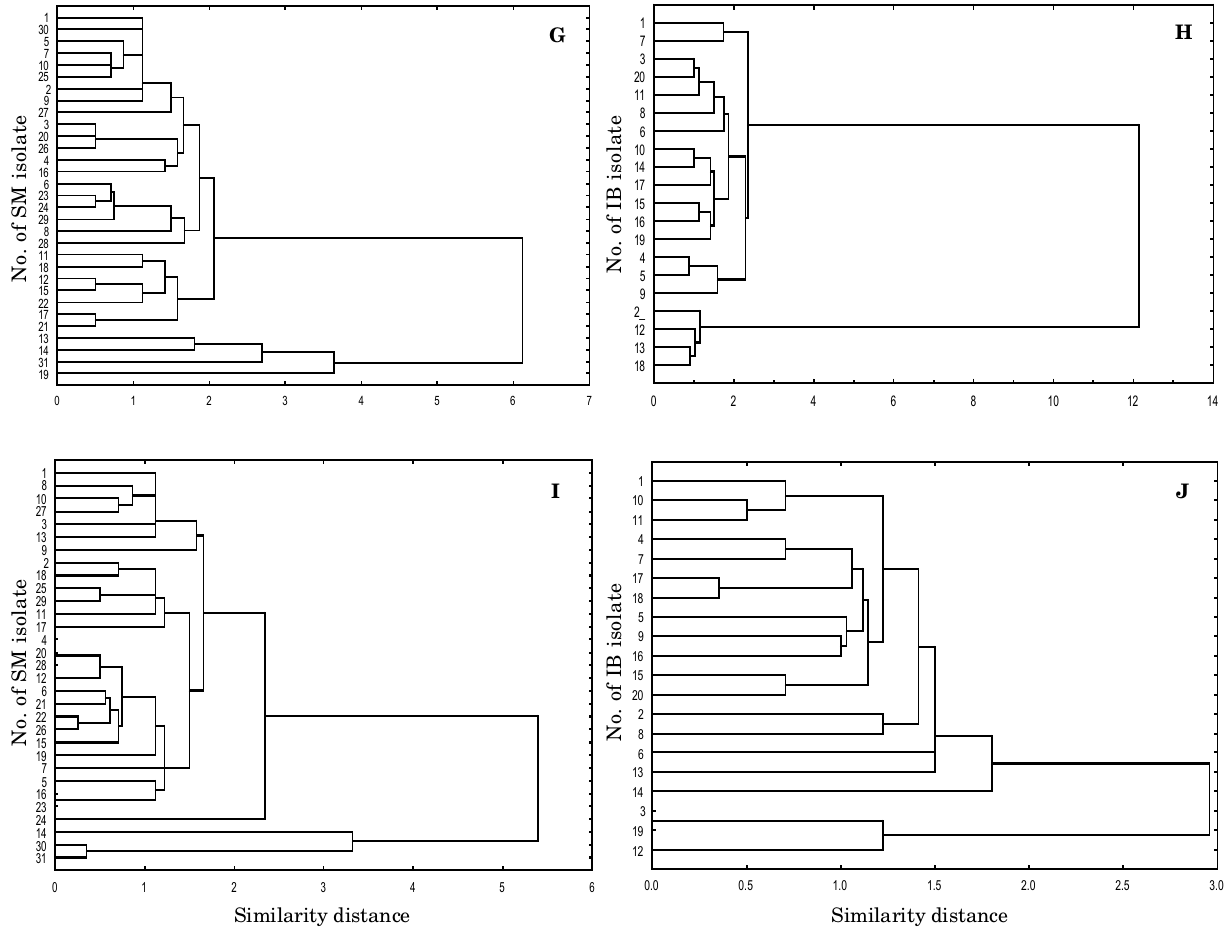
cluster fell into two groups, the first containing isolates IB3, 17, 4 and 5, which clustered at a low- er level of similarity, the second being in turn di- vided into subclusters, with isolates IB2 and IB18 in different subclusters. The phenogram representing the 31 isolates from eggplant against A. tenuis is shown in Figure 2E. This phenogram fell into two main groups which clustered at a very low level of similarity, with an average distance of 3.3. The first group contained isolates 8 and 9. The second group was divided into two subclusters. In one of these sub- clusters isolates 30 and 31 were contained in the same groups, indicating a high level of similarity. In Figure 2F, representing the 20 isolates from sweet potato against A. tenuis, isolates 2 and